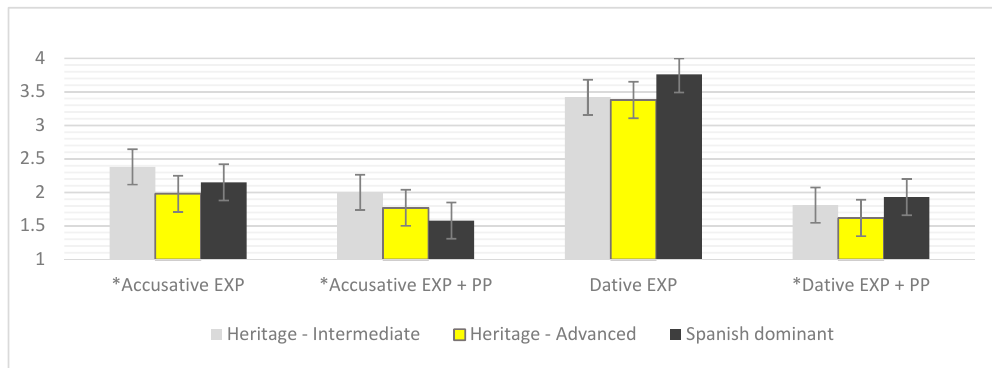
Figure 3. Judgment task with written stimuli—mean ratings for Class III verbs.